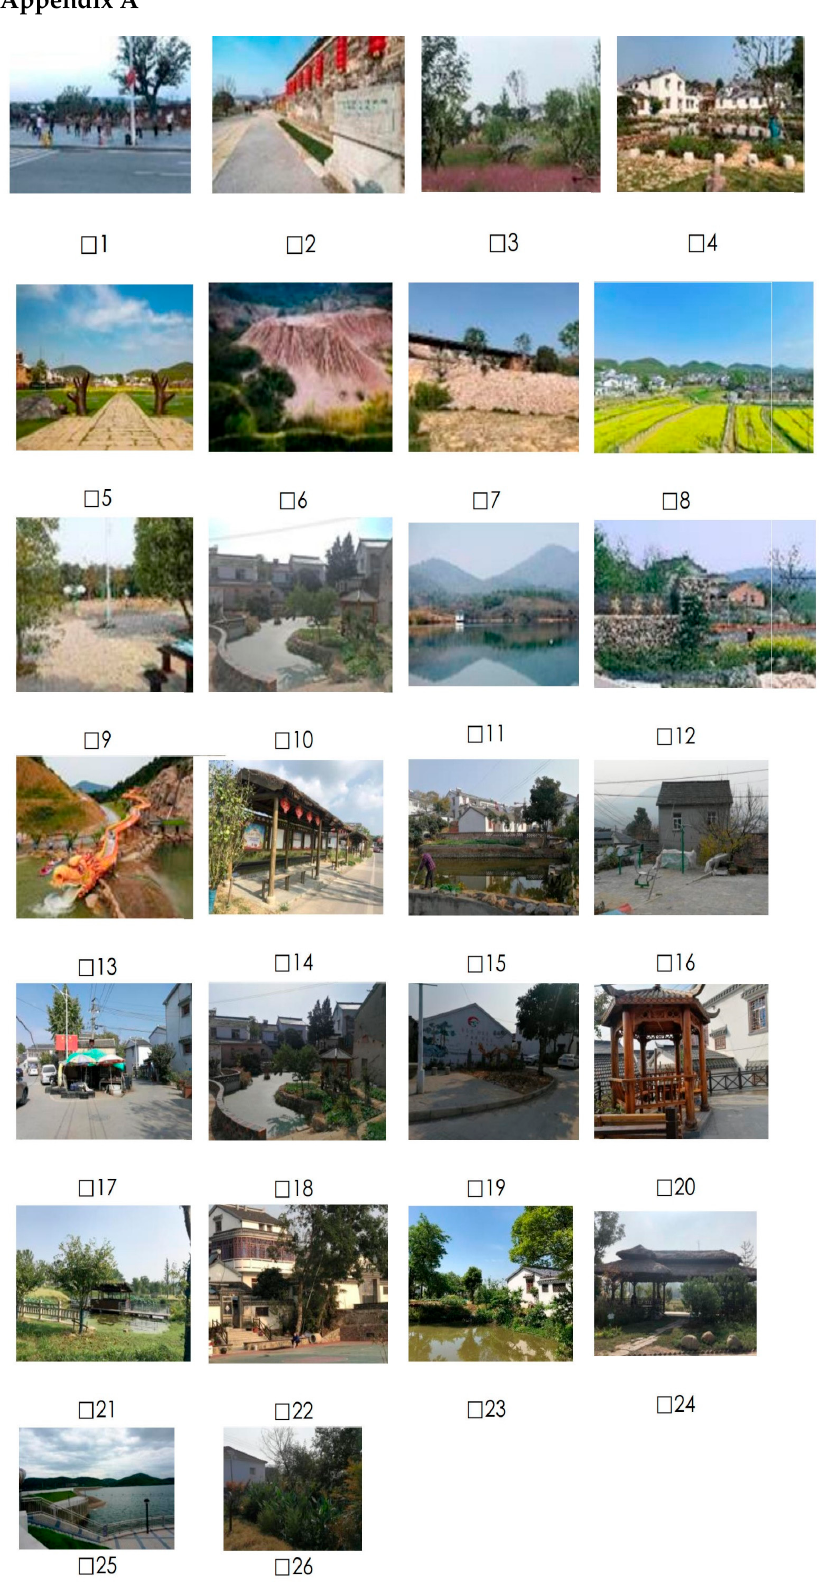
Figure A1. Resident Cognitive Questionnaires.